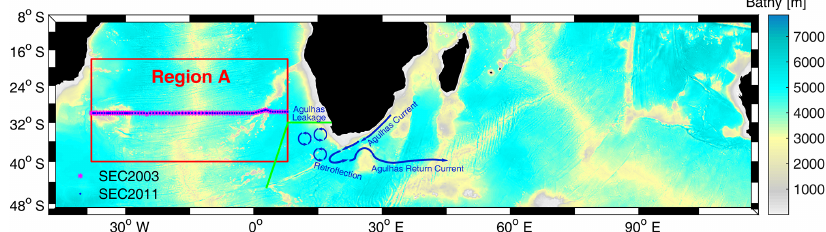
Figure 2. Bathymetry of the South Indian–Atlantic oceans. Color shading is ocean depth. Red box delineates the area for the basin-wide average of gridded data (hereafter referred to as Region A). The green line shows the Good Hope section, which is used to calculate the leakage transport to the South Atlantic. Magenta stars represent transatlantic CTD stations measured in 2003, with blue dots showing the 2011 measurements. The Agulhas Current, Retroflection, Agulhas Return Current and Agulhas Leakage (as eddies) are also